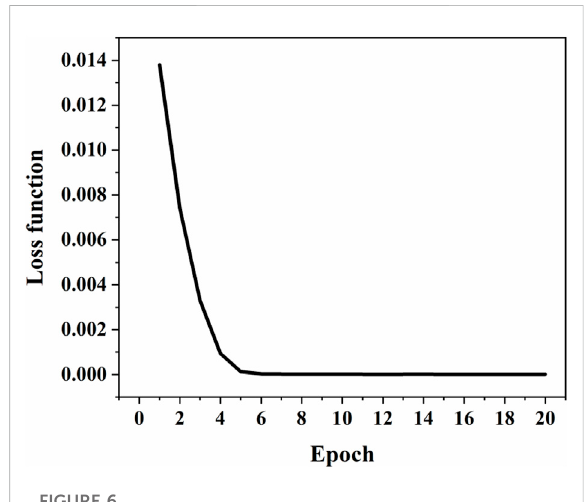
FIGURE 4 The performance comparison of the deep learning neural networks using different number of hidden layers with the corresponding CPU time.